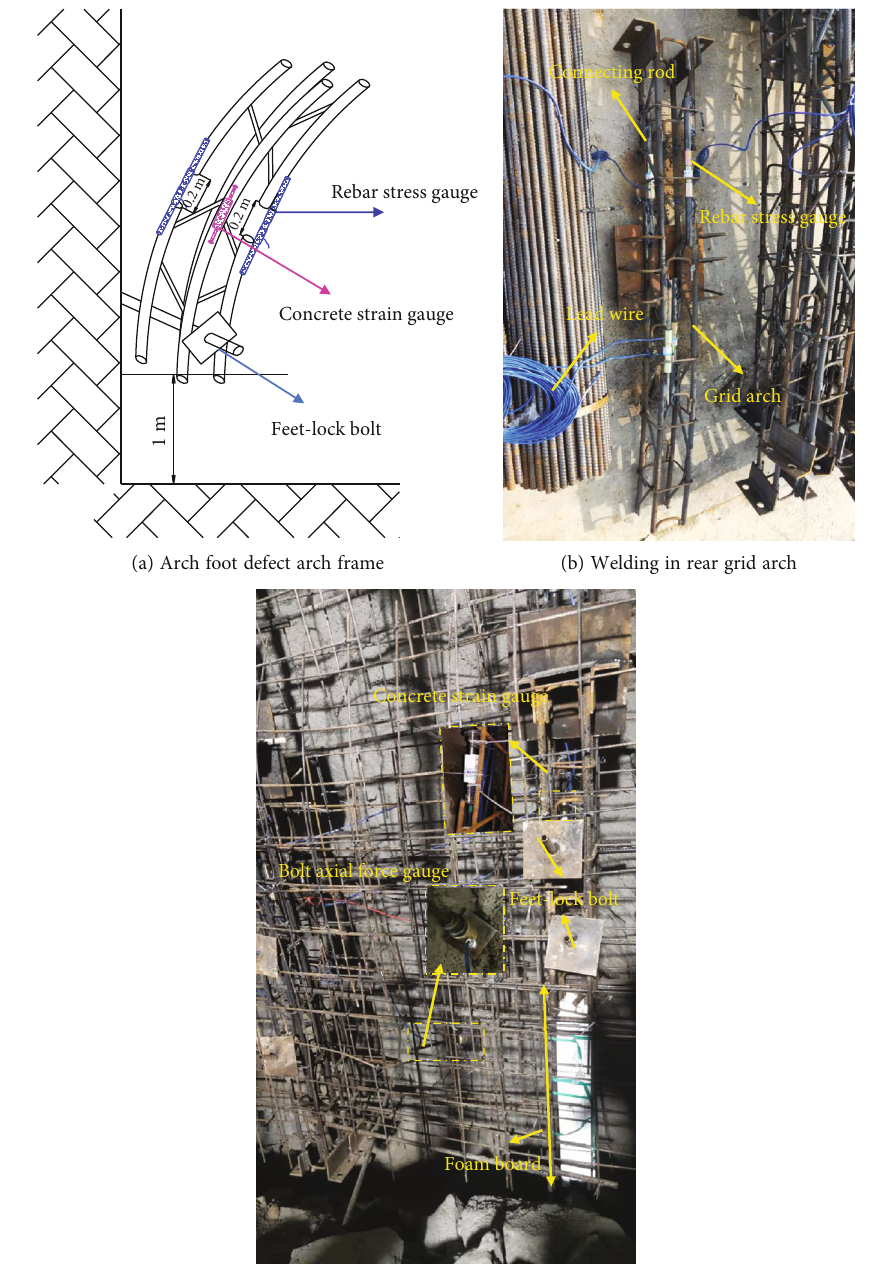
Figure 1: Test design scheme and